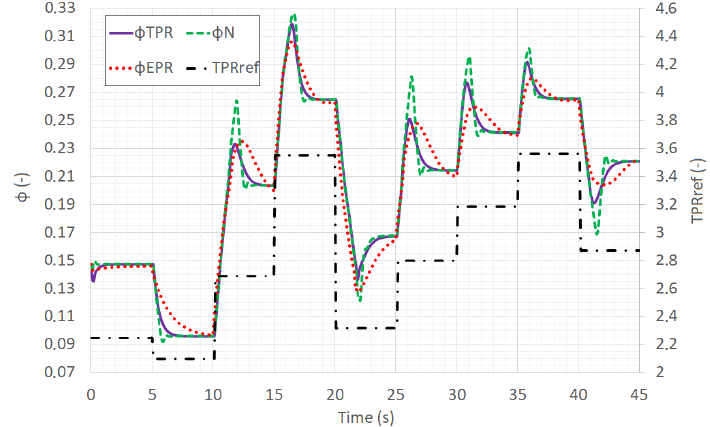
Figure 10. Fuel-air equivalence ratio changes due to different control parameters.